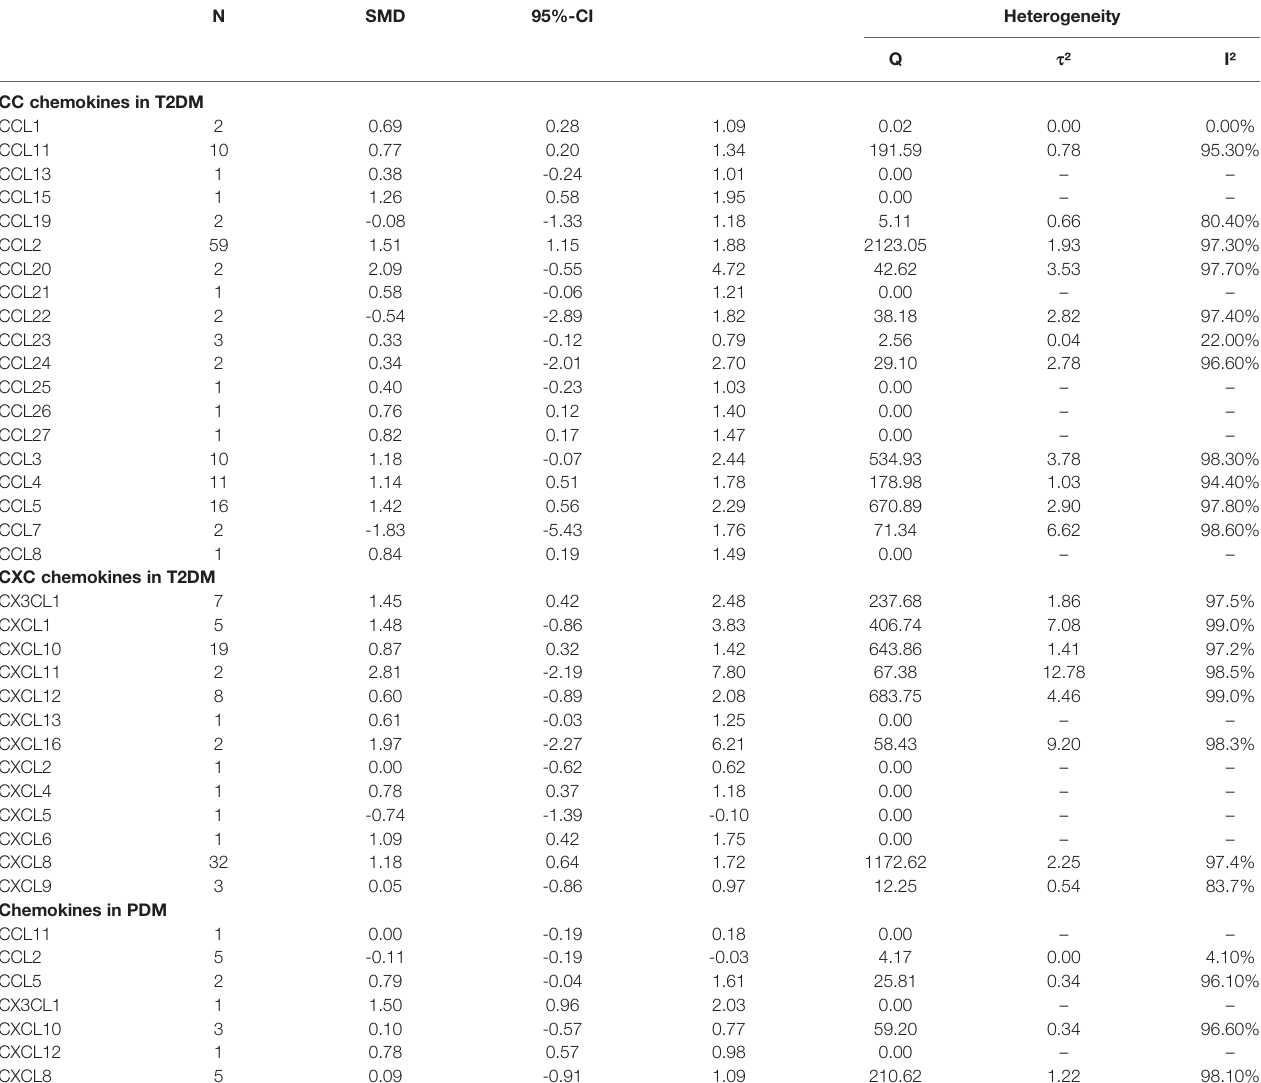
TABLE 2 | Subgroup analysis of chemokines between T2DM and PDM participants and